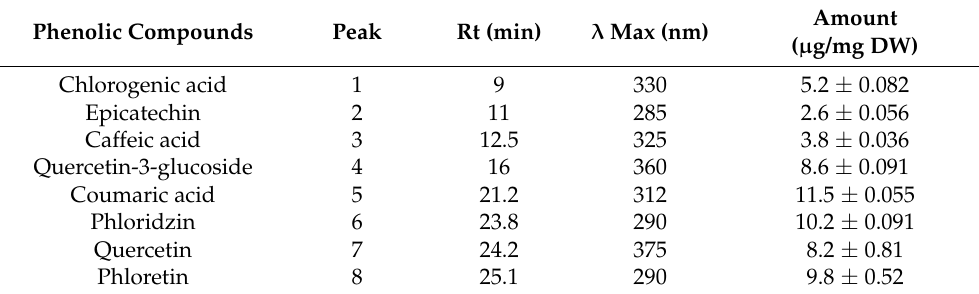
Table 1. HPLC Quantification and Concentration of Polyphenolics from Apple Pomace.